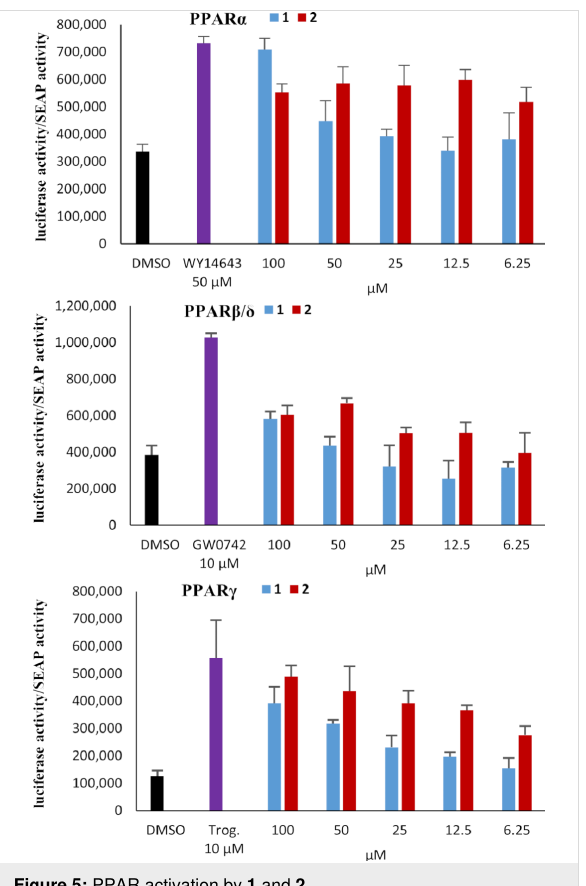
Figure 5: PPAR activation by 1 and 2